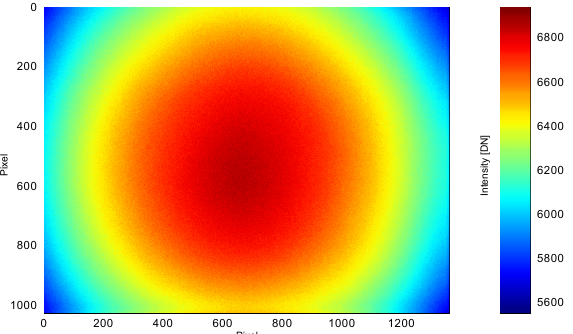
Figure 3: Flat field image (FFI) of the integration sphere, aver- aged over 100 images.